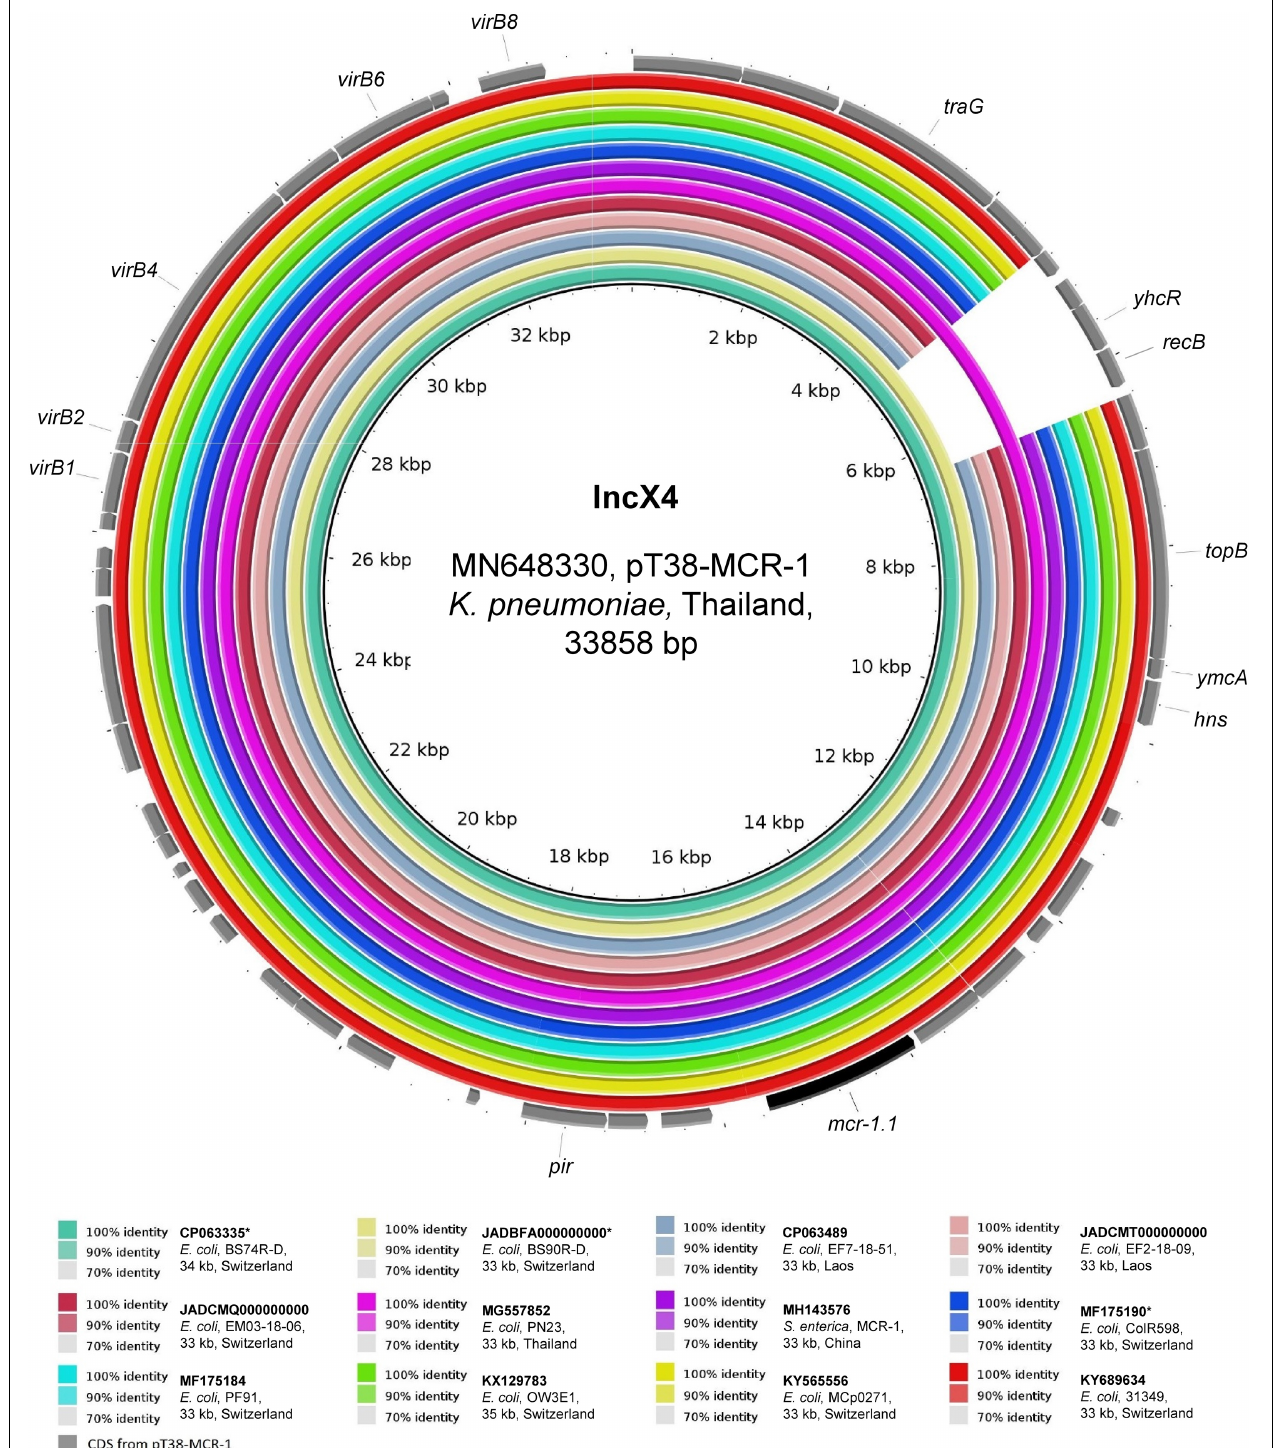
FIGURE 3 | BLASTn comparison of IncX4-type plasmid sequences. The IncX4-type plasmid sequences from the present study were compared to other sequences that were selected based on high homology in a BLASTn search against the NCBI non-redundant nucleotide collection (on 10.11.2020). pT38-MCR-1 (GenBank accession: MN648330) was used as reference sequence. Rings were constructed using BRIG (BLAST Ring Image Generator) v.0.95. The colored rings represent similarities to the reference sequence. We report GenBank accession, species of isolation, strain name, sequence size and country of origin. CDS are represented as arrows in gray. The mcr-1.1 gene is shown in black. The asterisk (*) indicates strains from Swiss residents with travel history to Asia.